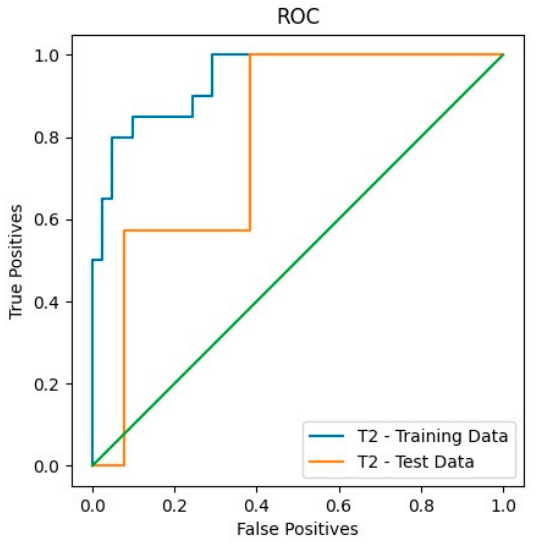
Figure 3. Receiver operating characteristic curve of the model using T2-weighted images as input.